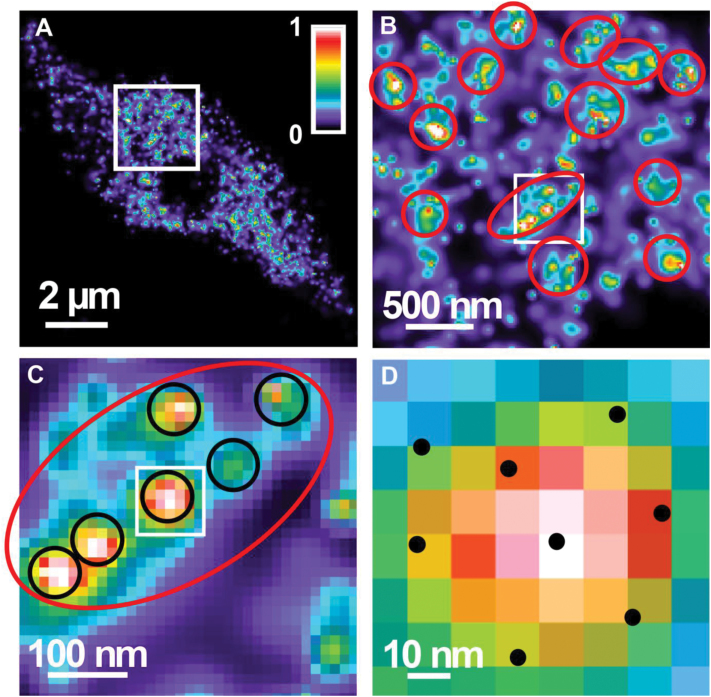
Distribution and aggregation of RNAPIISer2ph (false coloured in a heat map with the intensity colour code indicated). (A) Distribution in a 110nm slice of an 8C nucleus. (B) Enlarged image of the boxed area in (A). Red circle and ellipses represent large clusters. (C) Enlarged image of the boxed area in (B). The red ellipse and the black circles represent large and small clusters, respectively. (D) Enlarged image of the boxed area in (C). Black dots represent single molecules.